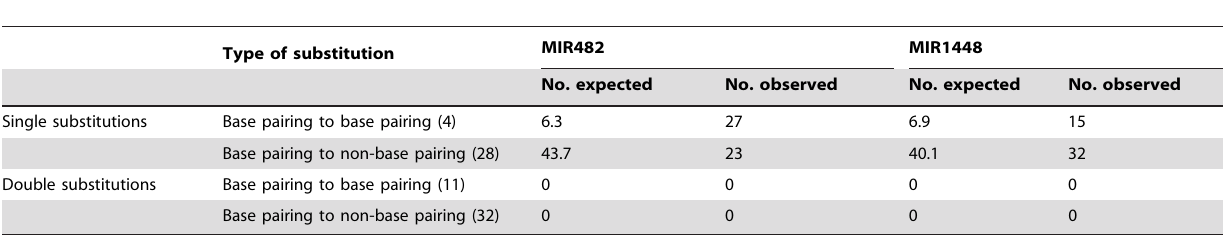
Table 3. Substitutions observed in pre-miR482 and pre-miR1448 in Populus , on the basis of the secondary structure of Populus alba clone